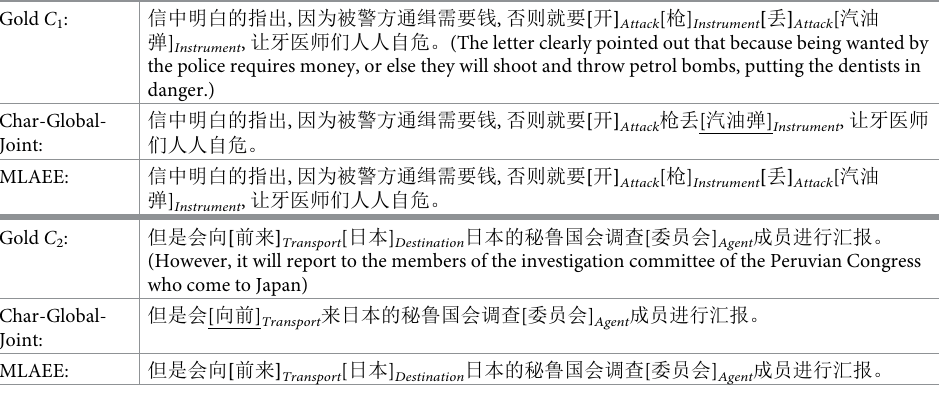
Table 4. Event prediction made by different models. Gold C i indicates the standard annotation. Words in bold and italics are correct triggers and arguments, respectively, while the underlined ones are incorrect. Gold C 1 : 让牙医师们人人自危。 (The letter clearly pointed out that because being wanted by Instrument , the police requires money, or else they will shoot and throw petrol bombs, putting the dentists in